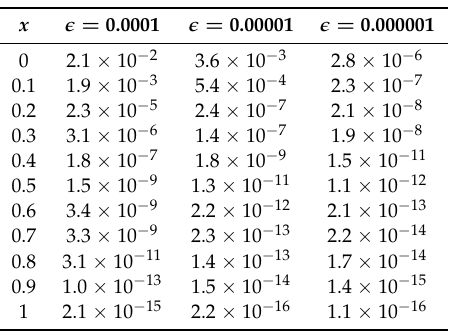
Table 1. The error for (cid:101) = 0.0001, 0.00001, and 0.000001.